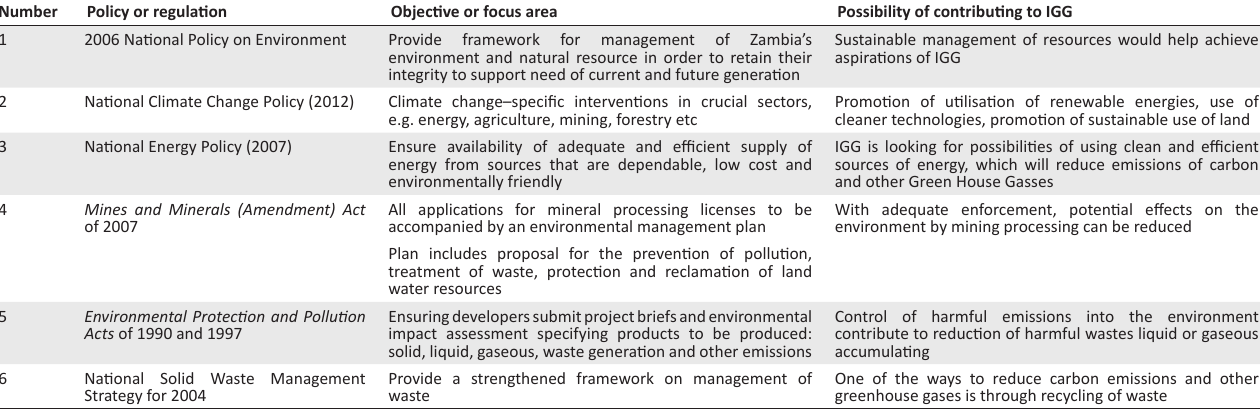
TABLE 3: Policies and regulations on environmental protection in Zambia and their possible contribution to achievement of Inclusive Green Growth or green economy. Number